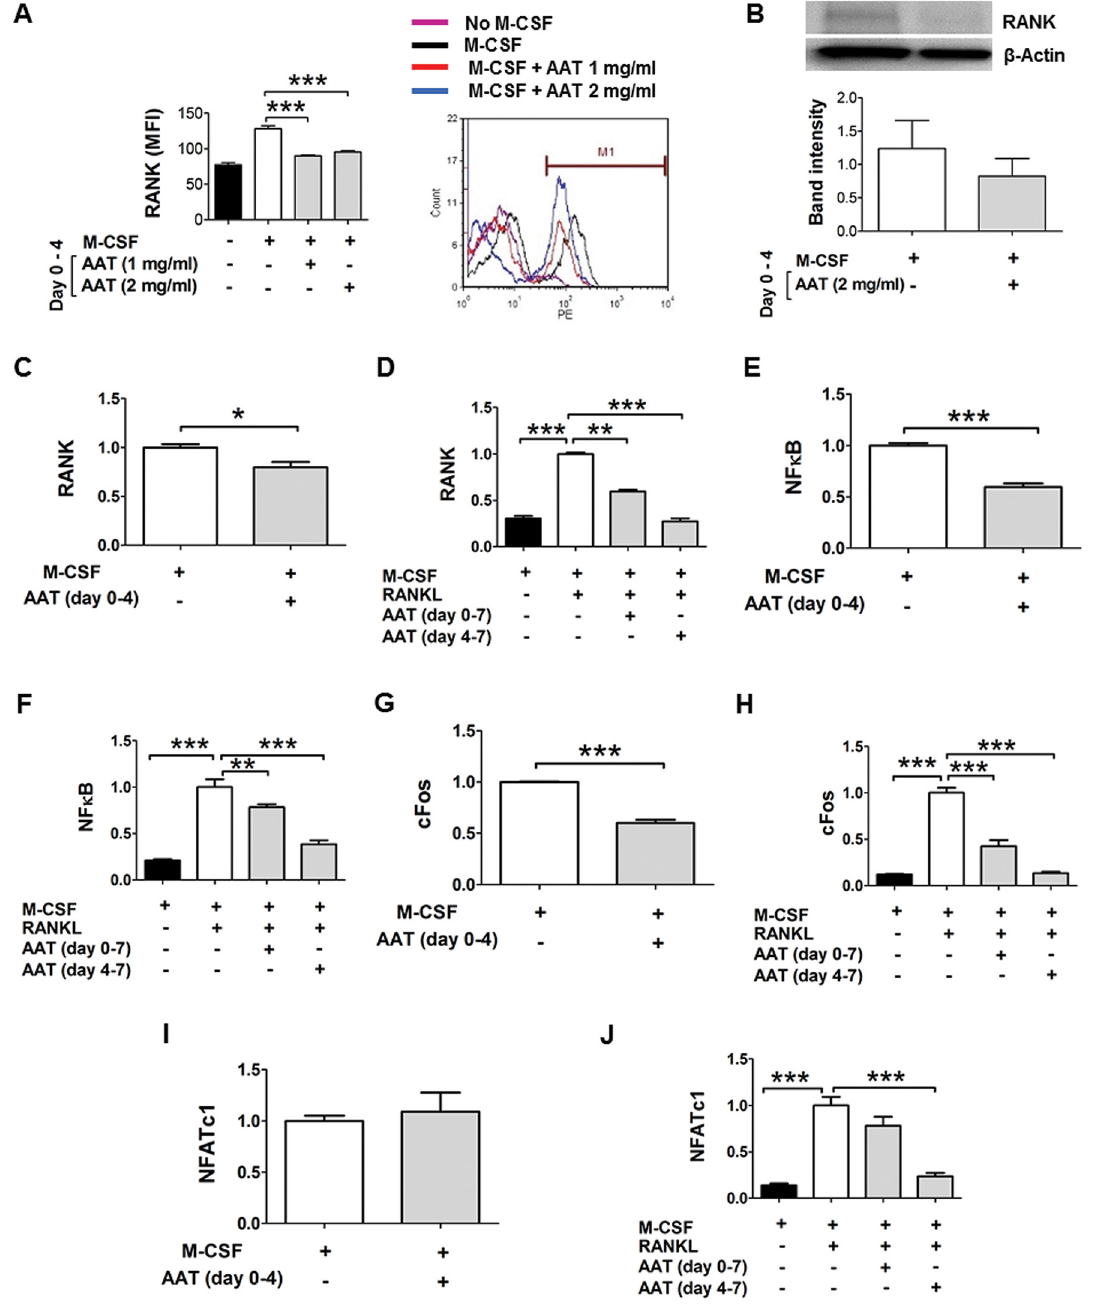
Figure 4. AAT inhibits RANK and related gene expression in OCP cells. BMM cells were treated with M-CSF for 4 d in the presence or absence of AAT as indicated and stimulated by RANKL (Day 4–7). (A) Cell surface RANK receptors detected by flow cytometry expression. Left panel, the mean fluorescence intensity of cell surface RANK receptor levels at d 4. (Right panel) The representative flow cytometry histogram (n = 5). (B) Western blot analysis for detection of total RANK protein at d 4. (Upper panel) Representative image of Western blot. (Lower panel) RANK protein band intensities of four individual experiments. Band intensity was analyzed with Image J software. (C–J) Relative gene expression (mRNA) levels (fold changes) detected by quantitative real-time PCR. (C) RANK at d 4. (D) RANK at d 7. (E) NF k B at d 4. (F) NF k B at d 7. (G) cFos at d 4. (H) cFos at d 7. (I) NFATc1 at d 4. (J) NFATc1 at d 7. Values are means ± SEM of at least triplicate samples. Data were analyzed using one-way analysis of variance followed by Dunnett’s multiple comparison test. Student t test was used to compare two samples. * P <0.05, ** P <0.001, *** P